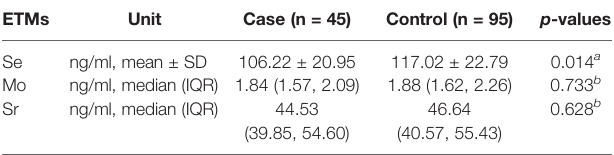
TABLE 2 | Comparisons of concentrations for Se, Mo and Sr between cases and